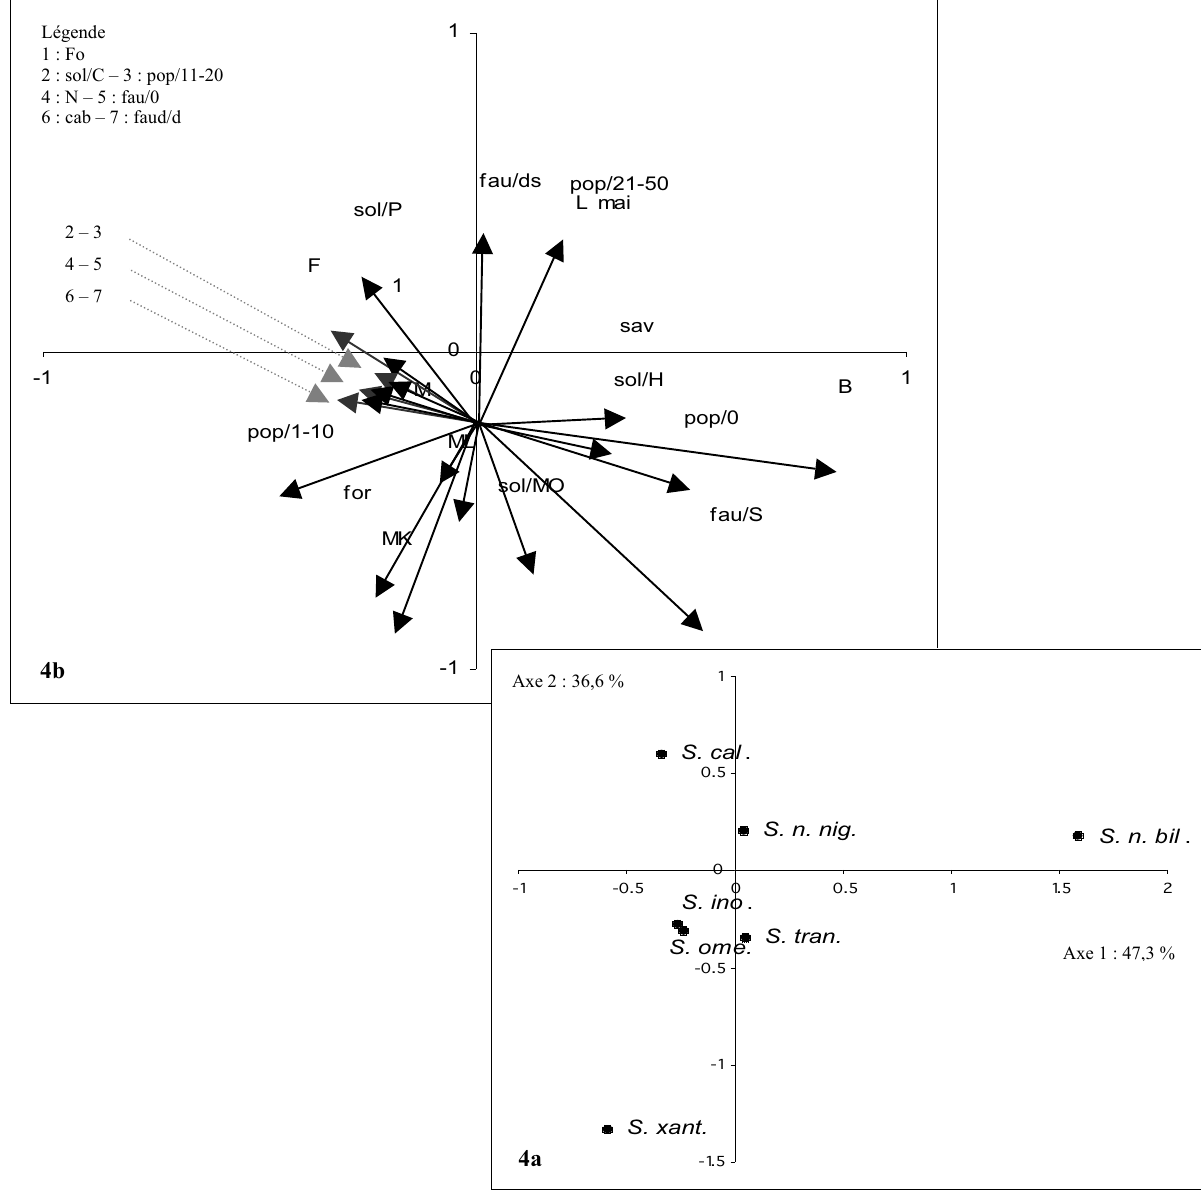
Fig. 4. – Diagramme d’ordination de l’ACC (plan des axes 1 et 2). La figure principale (4a) indique la distribution des espèces dans le plan ( S. tran. : S. transvittatus, S. ino. : S. inornatus, S. xant. : S. xanthomelas, S. cal. : S. calcitrans, S. n. nig. : S. niger niger, S. ome. : S. omega, S. n. bil. : S. niger bilineatus ). La figure complémentaire (4b) indique les corrélations (vecteurs) des modalités des différents paramètres environnementaux avec les deux premiers axes (abréviations conformes au tableau I et à la figure